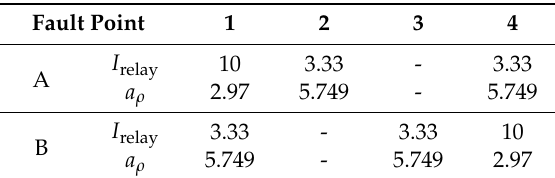
Figure 3. A single end system with parallel feeders. Table 2. a ρ Constants and relay currents for Case